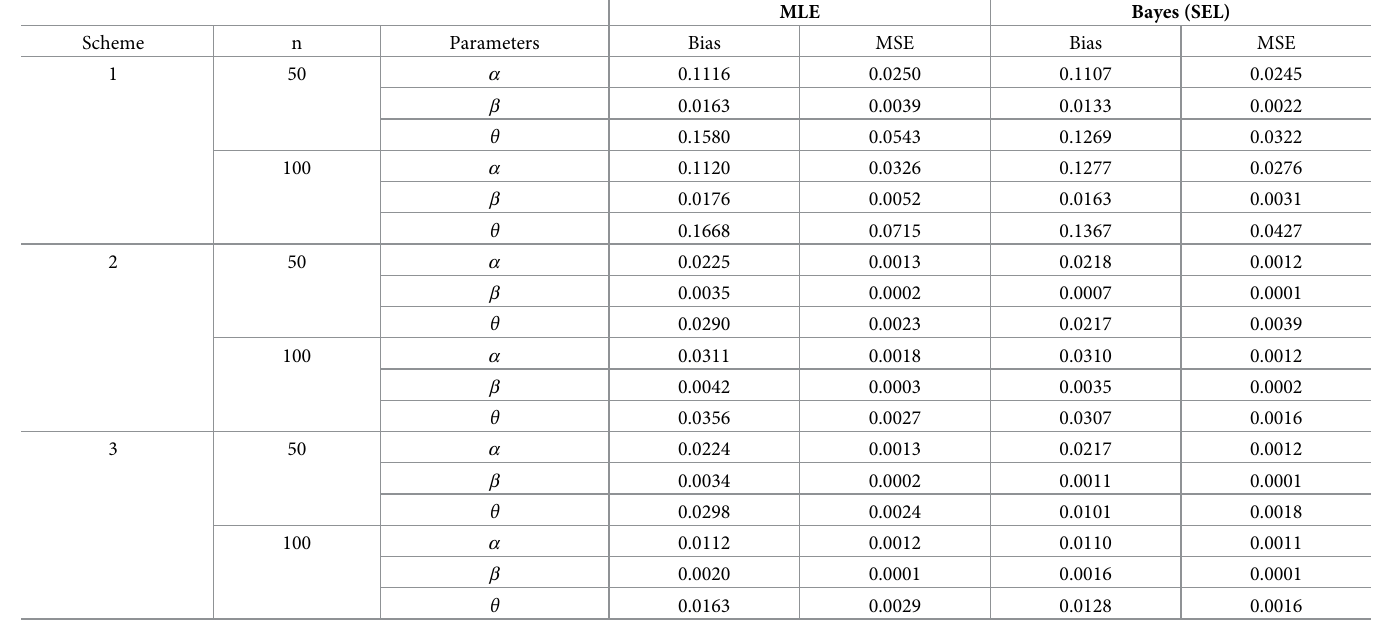
Table 4. MSEs and biases for MLEs and bayes estimators of α = 2, θ = 1.5, β = 0.5.